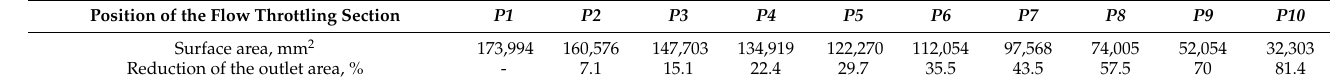
Figure 4. Presentation of the flow throttling method, where the symbol P indicates the remaining flow area ( P1 —open flow). Table 2. Values of flow throttling.